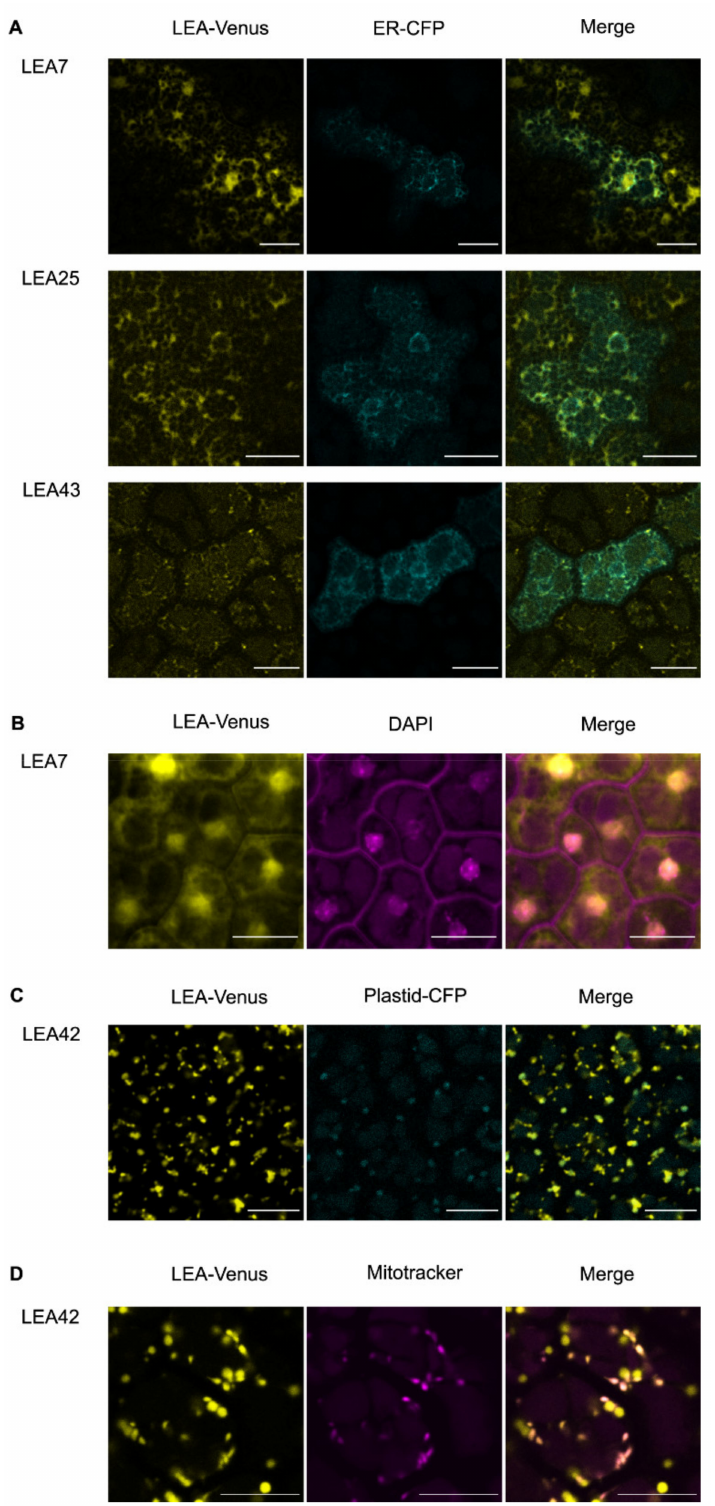
Figure 1. Subcellular localization of LEA7, LEA25, LEA42, and LEA43 in ( A ) ER, ( B ) nucleus, ( C ) plastids, and ( D ) mitochondria in embryos of dry seeds. proLEA_4::LEA_4:Venus lines were either crossed with an organelle marker line with CFP fluorescence (ER-ck or Pt-ck) or the dissected embryos were stained using organelle-specific dyes (DAPI or Mitotracker). Bars indicate 10 µ m. Additional LEA proteins with similar localization are shown in Supplementary Figures